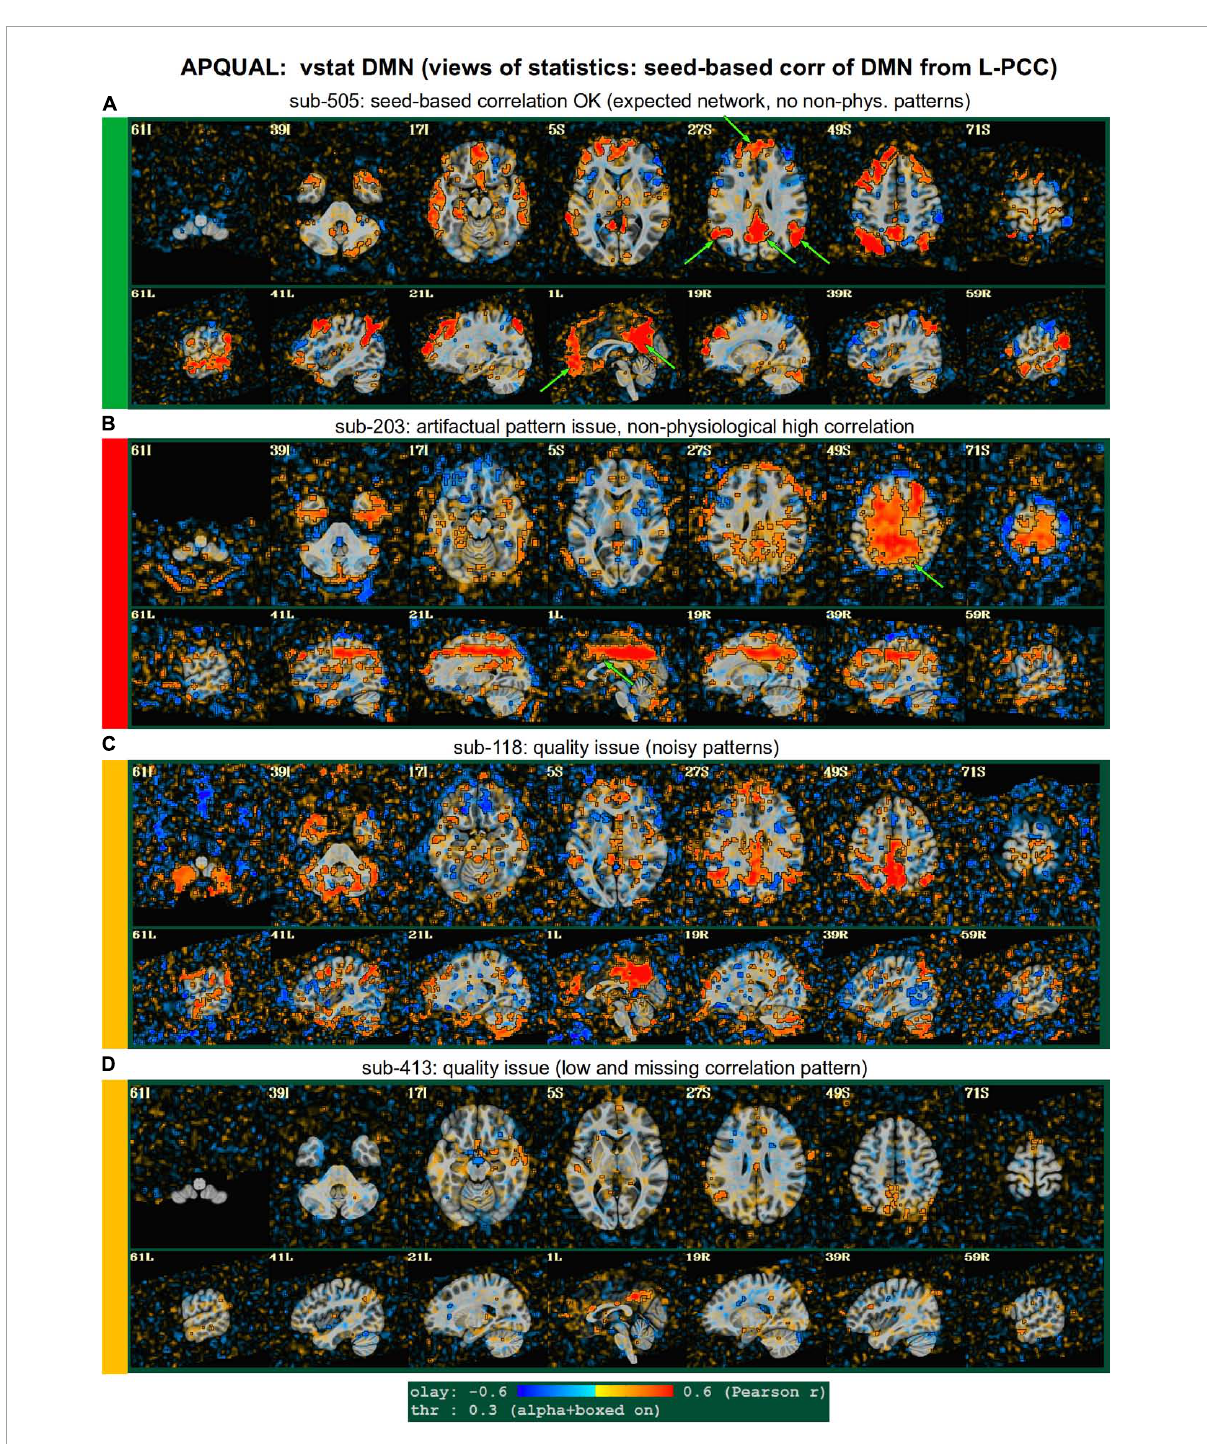
FIGURE4 APQUAL examples for the “vstat” QC block: Visualizations of statistical information after regression modeling [here, the seed-based correlation map showing the default mode network (DMN]). The Pearson correlation values are overlaid, and are also used for thresholding, which is applied transparently: Suprathreshold voxels are opaque and outlined in black, while sub-threshold values are also shown but with opacity decreasing with value. This “highlighting” form of thresholding is applied here and below. (A) Expected regions are present, and high correlation regions show network-related spatial specificity (some noise, blurring, and asymmetry are expected). (B) A large, non-physiological region of high correlation is shown, and appears to be artifactual. (C) The expected network is discernible, but there is notable noise and distortion. (D) Almost no intra-network correlation is